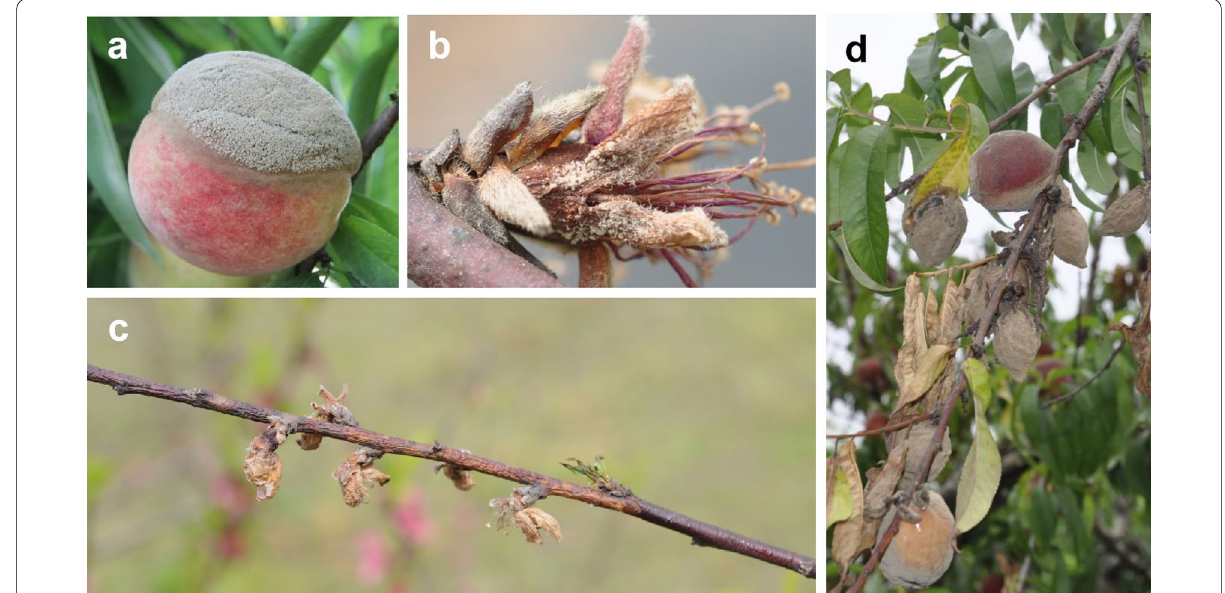
Fig. 1 Symptoms of peach brown rot and blossom blight. a Fruit rot with sporulating lesion (Wuhan, 2012). b Blossom blight (Wuhan, 2018). c Twig canker (Wuhan, 2018). d Twig dieback due to multiple infections (Wuhan,